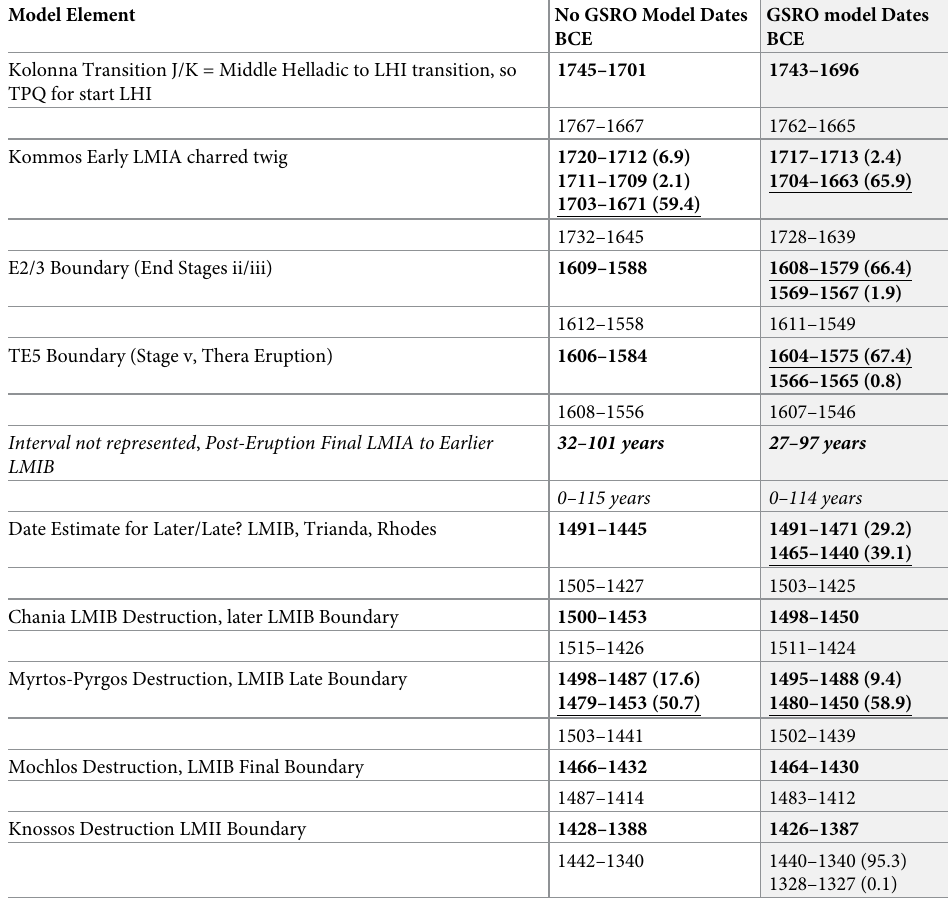
Table 3. Results (bold = 68.3% hpd, and non-bold = 95.4% hpd) for selected elements from Model 2 (Fig 12), typi- cal examples. As in Model 1 (Fig 9), a LnN(ln(3),ln(2)) constraint is applied to a Difference query for the period of time between the Thera eruption (TE5 Boundary) and stages (ii)/(iii) at Akrotiri (E2/3 Boundary). Results are shown for the model run without, and then with, the likely maximum possible GSRO for the southern Aegean (see above). The clear majority range, if present, where there are two or more split ranges is underlined. Note rounding errors sometimes see total hpd reported vary by up to 0.1%. Model